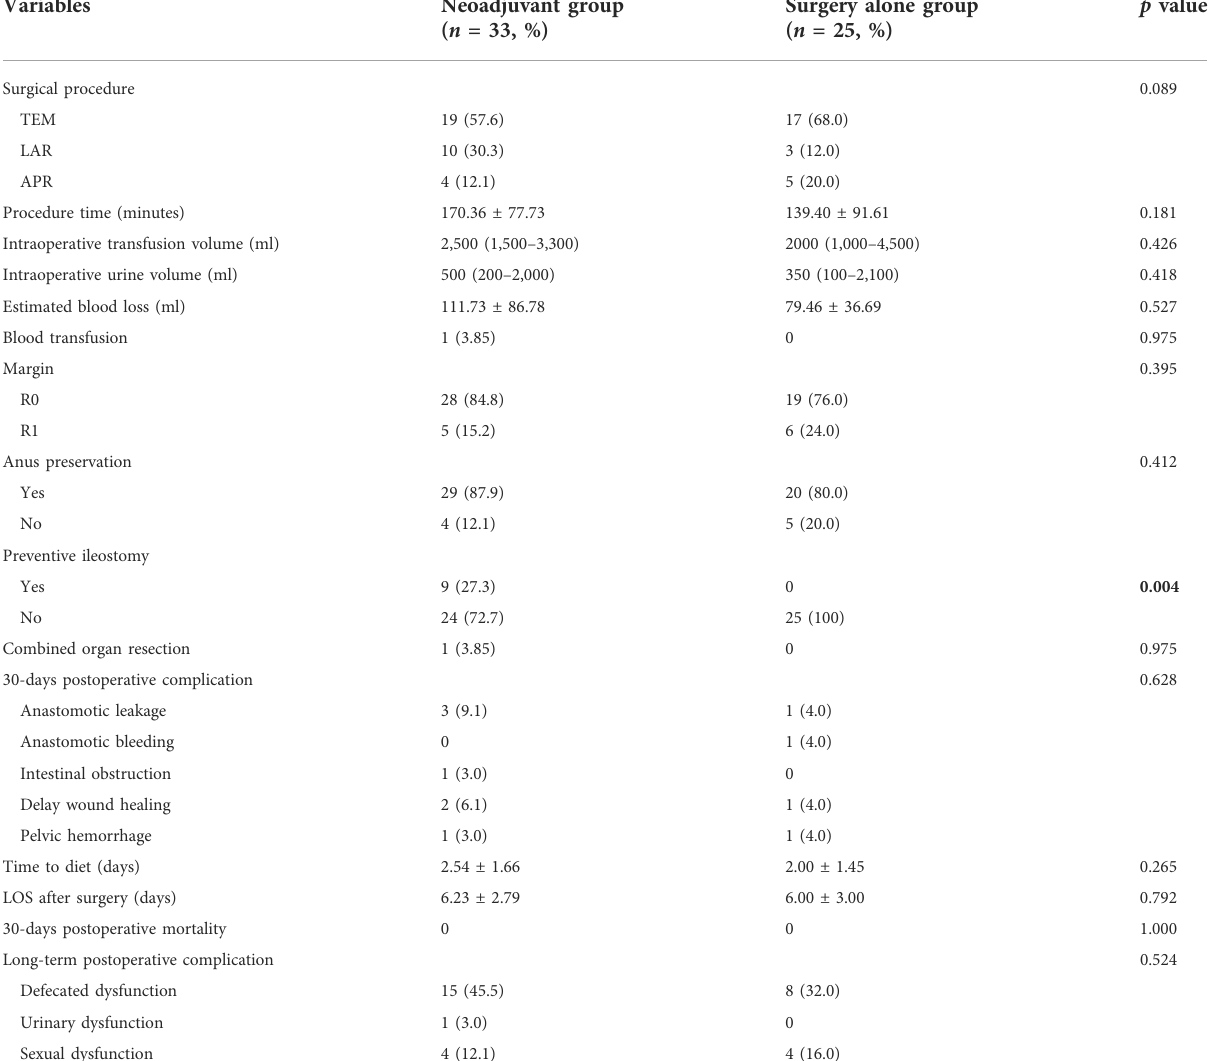
TABLE 4 Comparison of surgical outcomes of the 58 patients with locally advanced rectal GIST grouped by whether having received neoadjuvant imatinib therapy. Variables Neoadjuvant group